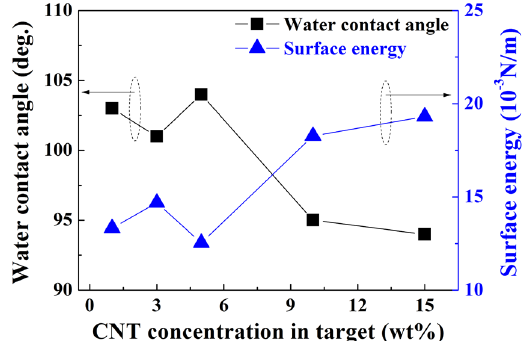
Figure 4. Water contact angles and calculated surface energies by Girifalco-Good-Fowkes-Young method of the fluorocarbon thin films as a function of the CNT concentration of the target.